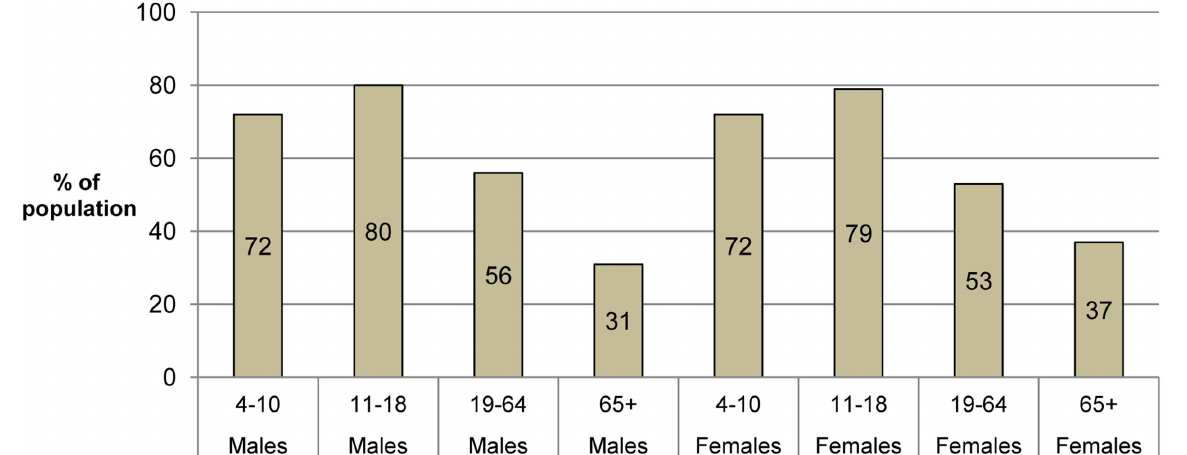
Fig 2. Percentage of England population who are SSB consumers by age group and gender. Data for England from NDNS 2008 – 10 [20].